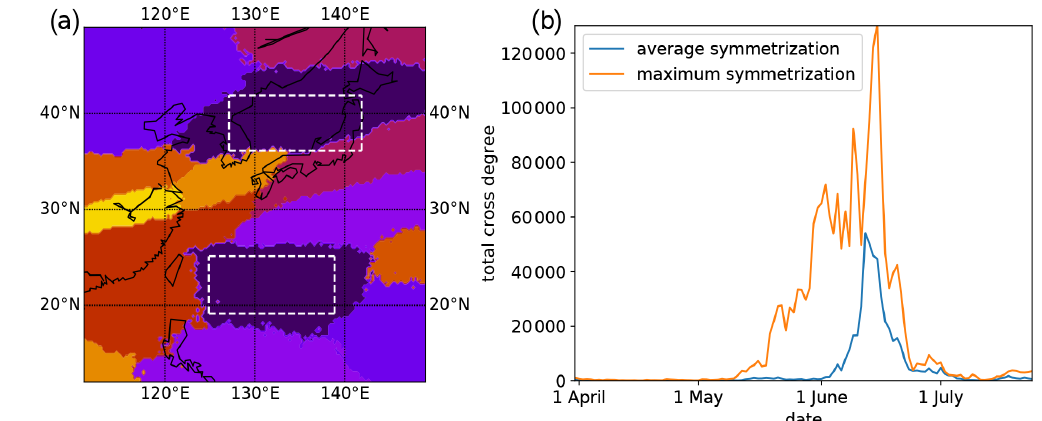
Figure 5. (a) Community structure of the network derived from heavy rainfall events between 14 June and 13 July of all years. (b) Total cross-degree between the regions marked by the white rectangles in (a) for 123 different networks computed from 30d windows starting between 1 April and 1